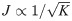
Within the restrictive bounds imposed by Eq (16), preserving effective connectivity can preserve correlations also in a complex network.Simulation results for the cortical microcircuit at full scale and with in-degrees reduced to 90%. Synaptic strengths are scaled as indicated, and the external drive is adjusted to restore the working point. Mean pairwise cross-covariances are shown for population 2/3E. Qualitatively identical results are obtained within and across other populations. The simulation duration is 30 s and covariances are determined with a resolution of 0.5 ms. To enable downscaling with J ∝ 1/K, the excitatory Poisson input of the original implementation of [58] is replaced by balanced inhibitory and excitatory Poisson input with a DC drive according to Eqs (19) and (20). A Scaling synaptic strengths as J∝1/K changes the mean covariance. Light green curve: stretching the covariance of the scaled network along the vertical axis to match the zero-lag correlation of the full-scale network shows that not only the size but also the temporal structure of the covariance is affected. B Scaling synaptic strengths as J ∝ 1/K closely preserves the covariance of the full-scale network. However, note that this scaling is only applicable down to the in-degree scaling factor given by Eq (16), which for this example is approximately 0.9.